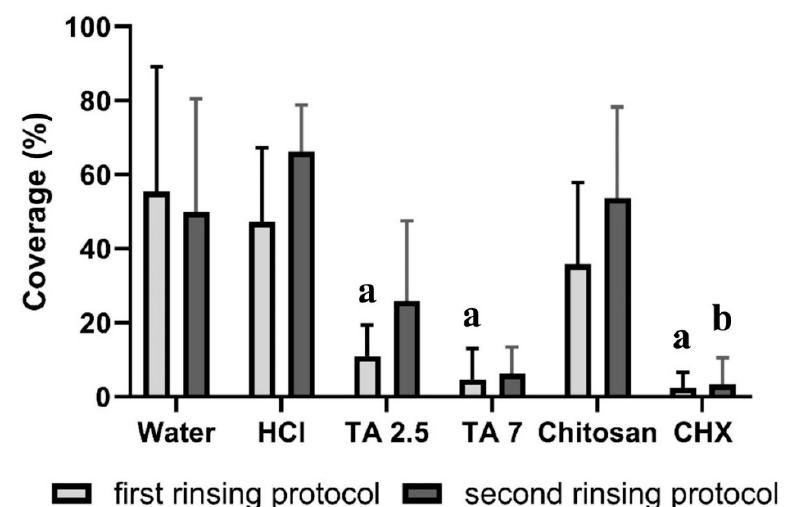
Figure 3. Coverage of specimens with bacteria in (%). The height of the bars corresponds to the mean value, and the line applied corresponds to ± the standard deviation. During two days of biofilm formation on bovine enamel specimens in situ, subjects rinsed 4 or 5 times with different experimental solutions. By using two different rinsing protocols, the immediate and long-lasting effects were tested. For the ex-vivo examination with a fluorescence microscope, the biofilm was stained with LIVE/DEAD ® BacLight™. Friedmann test: p < 0.05. Mouthwashes that differ significantly from water are marked with a for the first and b for the second protocol. HCl = hydrochloric acid, TA 2.5 = tannic acid (pH = 2.5), TA 7 = tannic acid (pH = 7) and CHX = chlorhexidine.